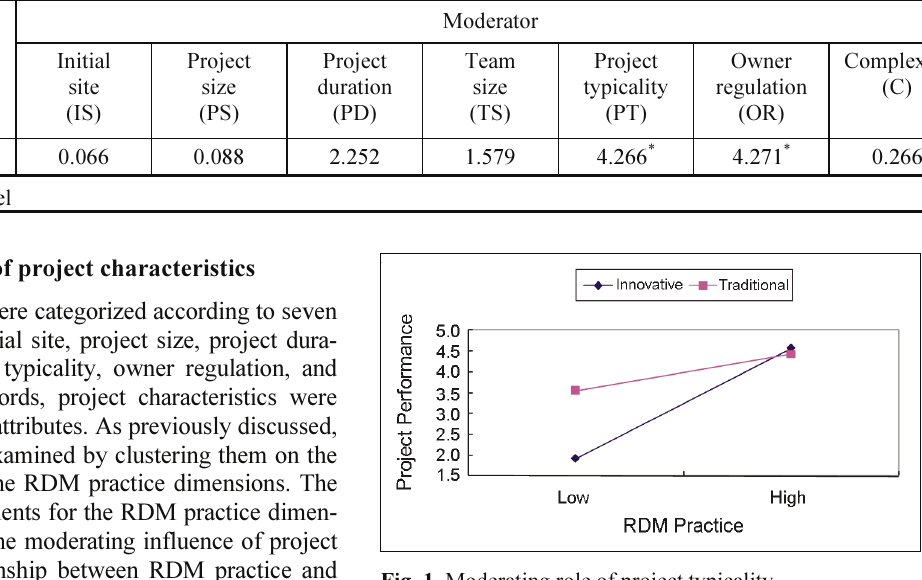
Fig. 1. Moderating role of project typicality